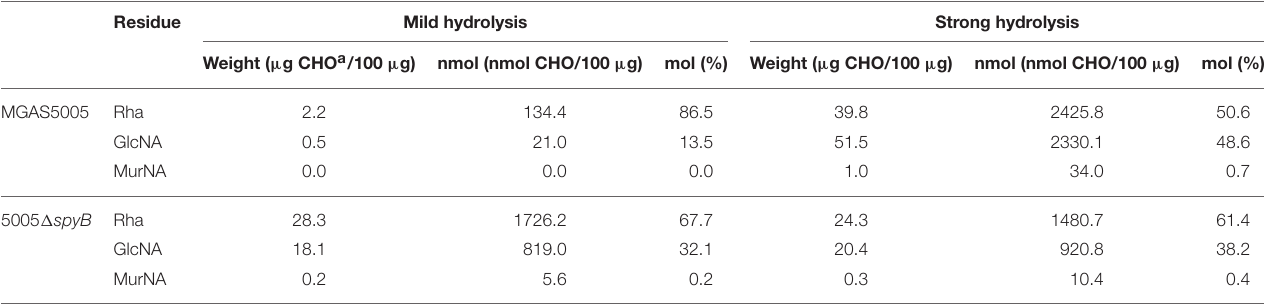
TABLE 1 | Glycosyl composition analysis of MGAS5005 and 5005 1 spyB cell wall.